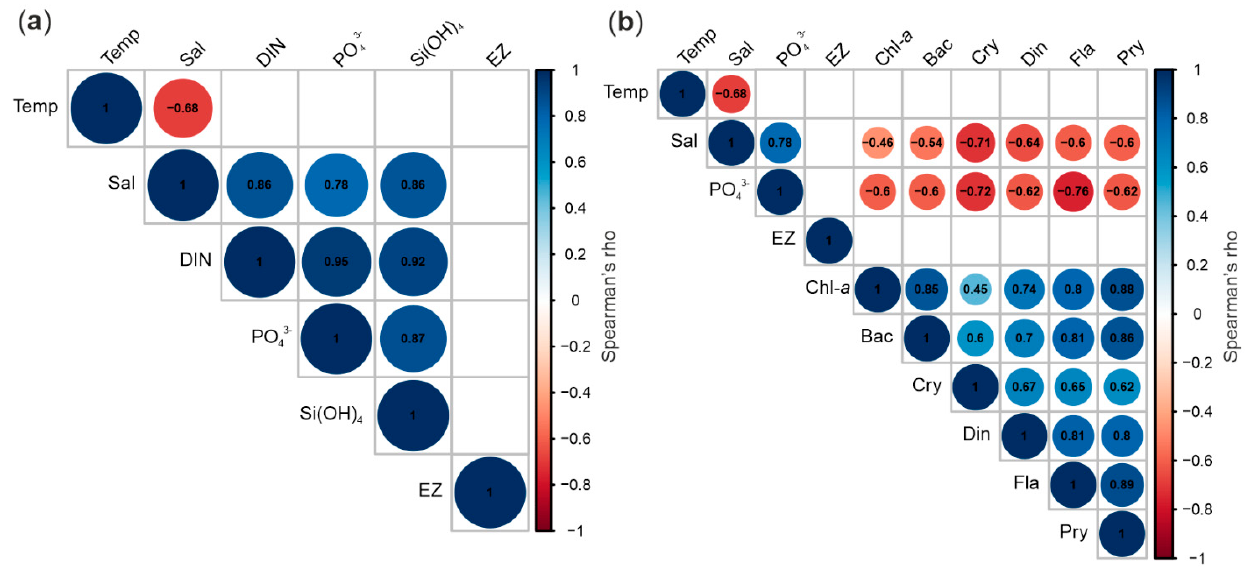
Figure 6. Correlation matrices (Spearman) among physical, chemical and biological variables: ( a ) the result of the analysis of relationships between all environmental data collected in the investigated period; ( b ) correlations between all biological and selected environmental variables (in the case of the most strongly correlated physical and chemical variables (rho between 0.8 and 1.0 ( − 0.8 and − 1.0)), only one parameter was included in the analysis). Blank spaces indicate a nonsignificant correlation defined by a p -value of >0.05. Variables: Temp (temperature), Sal (salinity), DIN (dissolved inorganic nutrients (NO 3 − + NO 2 − )), PO 4 3 − (phosphate), Si(OH) 4 (silicic acid), EZ (euphotic zone extension), Chl a (chlorophyll- a ), Bac (Bacillariophyceae), Cry (Cryptophyceae), Din (Dinophyceae), Fla (Flagellates indet.), Pry